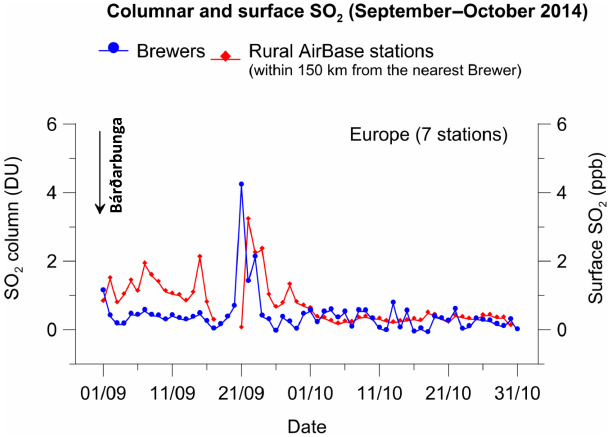
Figure 5. Mean surface SO 2 measured by AirBase class 1–2 sta- tions located within 150km from seven nearest Brewer stations in Europe as listed in Table 3. The arrow marks the starting date of the eruption (beginning on 31 August 2014 and continuing to be active throughout the whole bimonthly period and